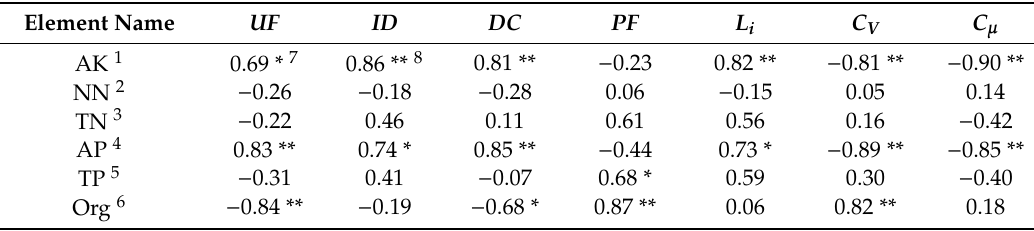
Table 7. Correlation analysis between cumulative content of nutrients in soil and the characteristic parameters of preferential